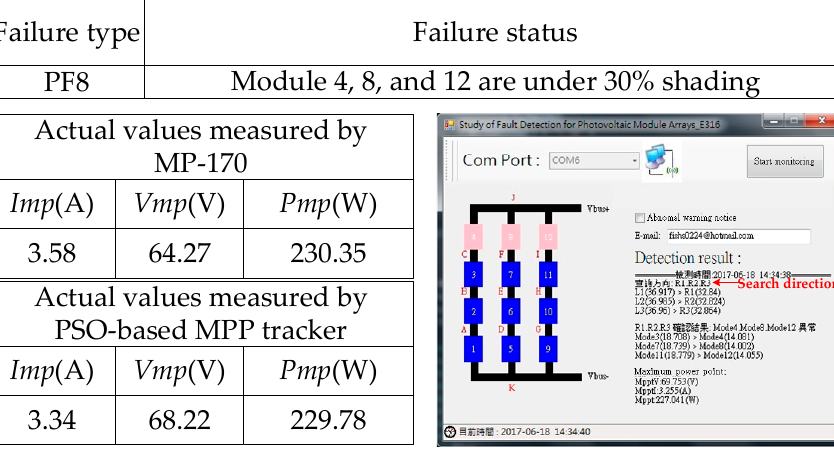
Figure 23. Experimental outcome for failure type PF8.